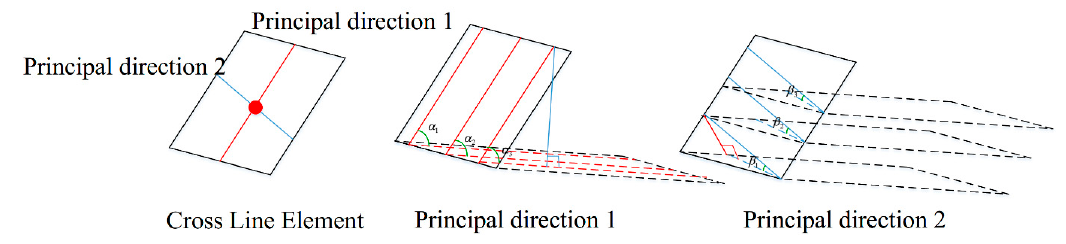
Figure 5. Cross-line element and its characteristic.